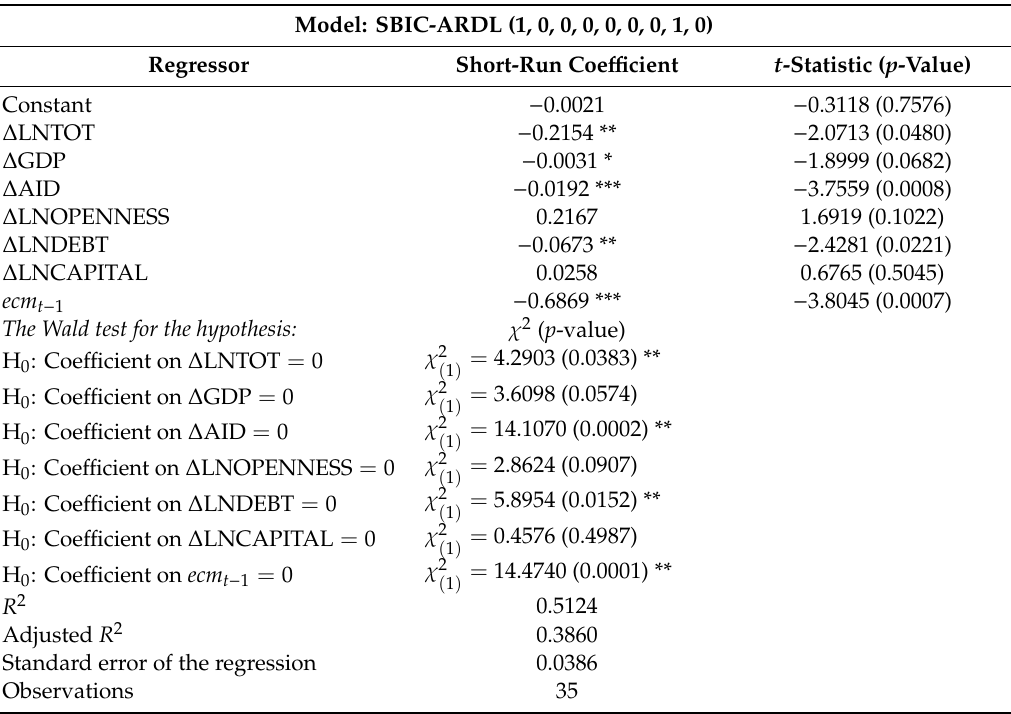
Table 3. Error-correction model (restricted